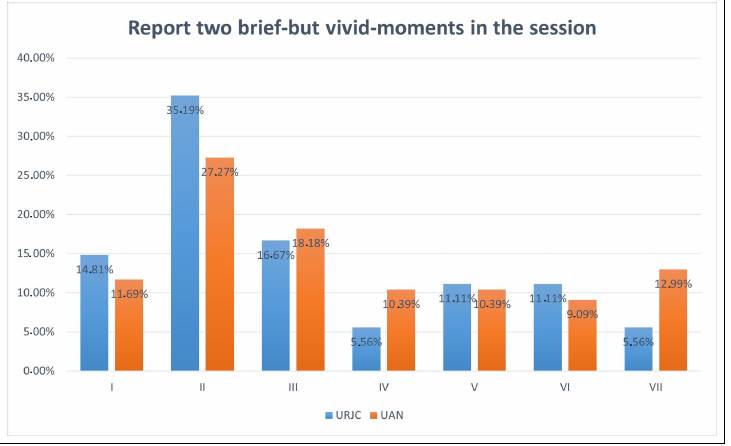
Figure 6. Answers to question 1: Report two brief-but vivid-moments in the session